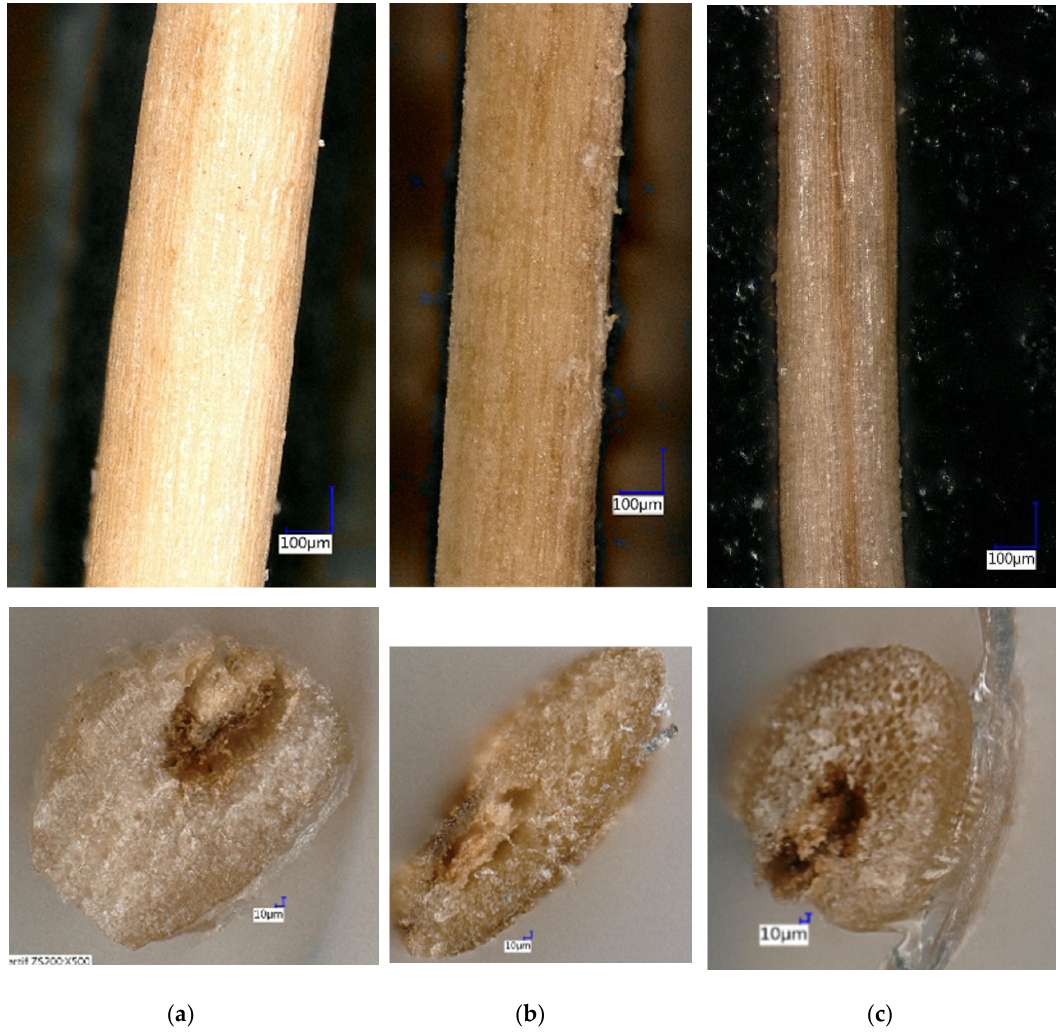
Figure 8. Microscope images of surface and cross-section of fiber: ( a ) raw fiber (RF); ( b ) alkali-treated fiber (ATF); ( c ) boiled fiber.